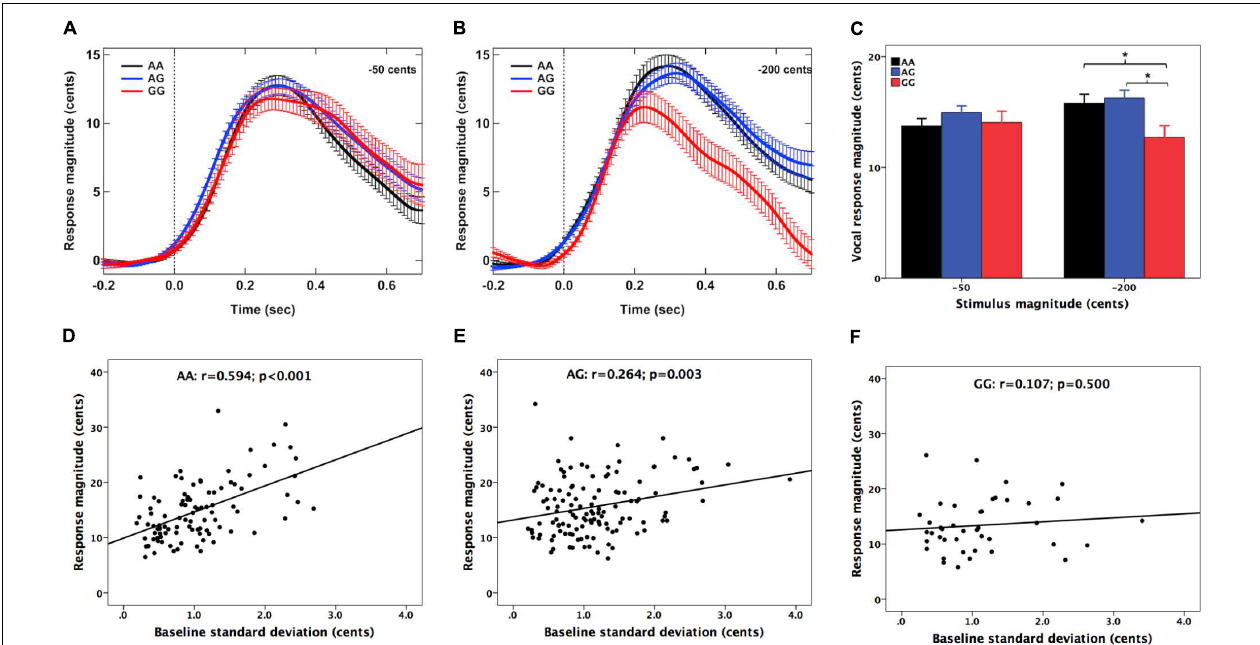
FIGURE 1 | (A,B) Grand-averaged voice F 0 contours in responses to –50 and –200 cents pitch perturbations for the AA (black), AG (blue), and GG (red) genotypes. Errors bars represent standard errors of the means (SEM). (C) T-bar plots of the magnitudes (mean + SEM) of vocal compensations across the genotypes, showing that the GG genotype exhibited significantly smaller magnitudes of vocal compensations for –200 cents perturbations relative to the AA ( p = 0.044) and AG ( p = 0.011) genotypes. The asterisk indicates significant differences in the magnitudes of vocal responses between the genotype groups. (D–F) Pearson correlation analyses revealed significant positive correlations between the magnitudes of vocal compensations and the SDs of the baseline F 0 for the AA ( r = 0.534, p < 0.001) and AG genotypes ( r = 0.264, p = 0.003) but not for the GG genotypes ( r = 0.107, p =